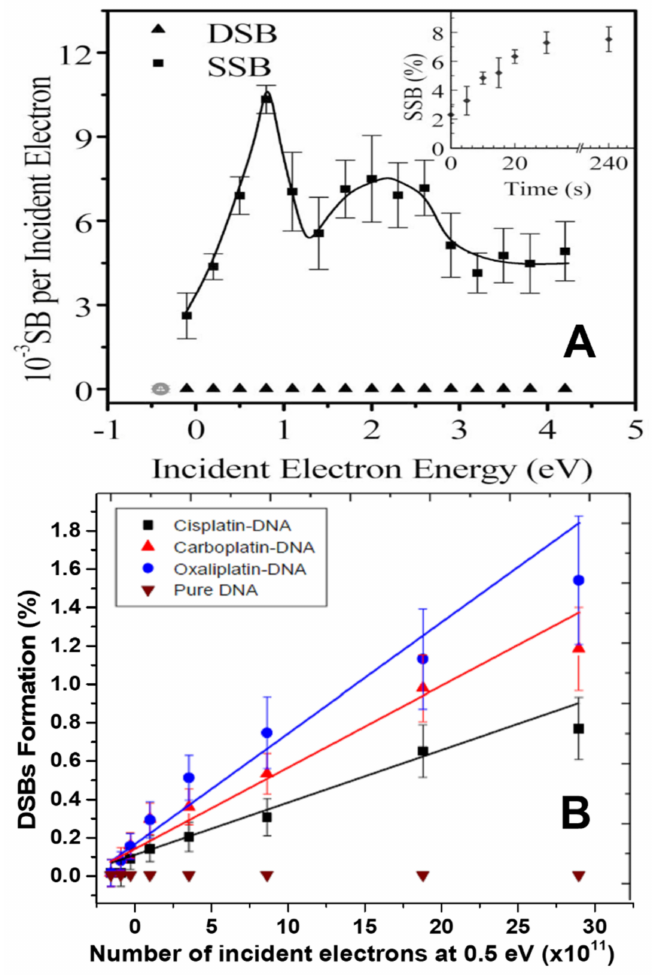
Figure 4. ( A ) Yields of DNA single strand breaks (SSBs) and double-strand breaks (DSBs) vs. incident electron energy. The inset shows the dependence of the percentage of SSBs on irradiation time for 0.6 eV electrons [128]. Copyright by American Physical Society. ( B ) Fluence-response curves for LEE-induced DSBs in 5-ML Pt-CA-plasmids and unmodified plasmid films induced by 0.5 eV incident electrons, which are adapted from [139]. The ratio of Pt-CAs to DNA was